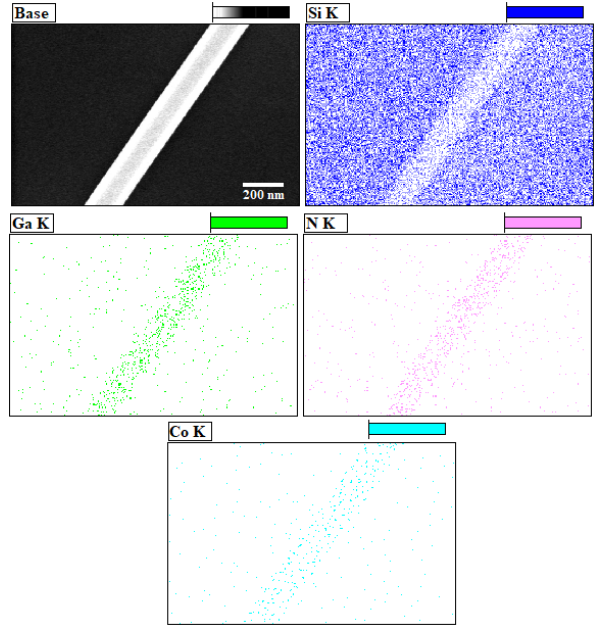
Figure 4. EDS mapping for dispersion of different elements involved in the synthesis of nanowires.